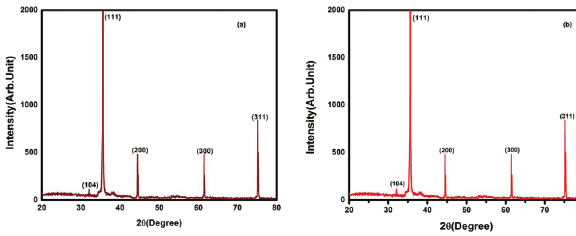
Figure 6: X-ray diffraction pattern of AgNPs (JCPDS No: 84-0713) of (a) A. bilimbi leaf and (b) Plum